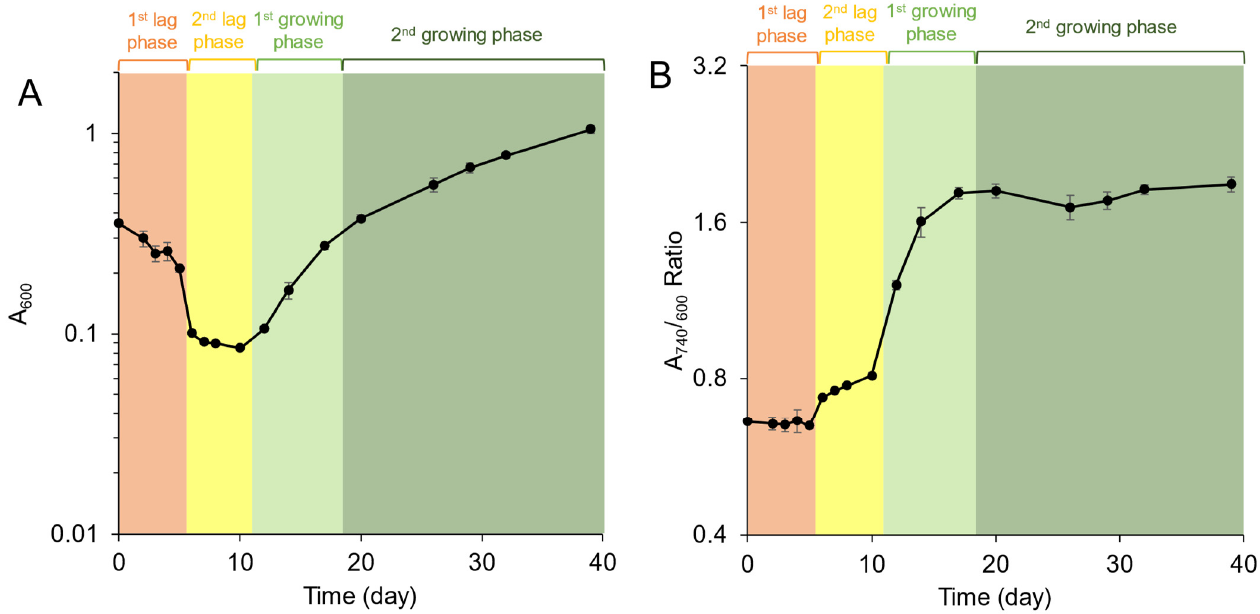
Figure 1. Photoheterotrophic growth profiles of C. aurantiacus represented by cell density values ( A ) and relative bacteriochlorophyll c contents ( B ). Measurements started after illumination. Orange, the first lag phase (days 0–5); yellow, the second lag phase (days 6–10); light green, the first growing phase (days 12–17); dark green, the second growing phase (days 20–39). The mean values of three measurements are shown with standard deviations.